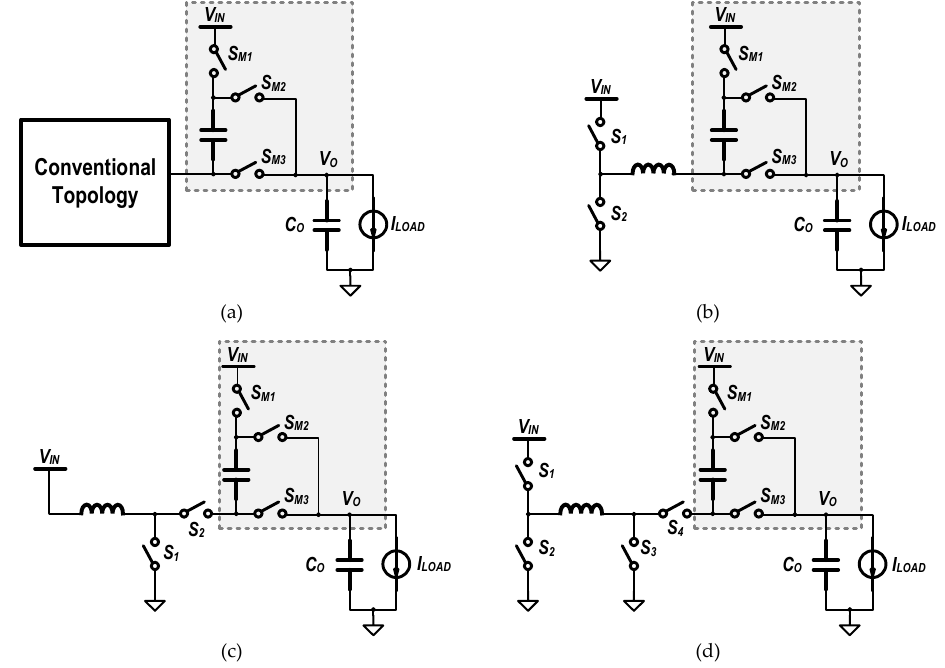
Figure 5. ( a ) Conventional topology with an energy transfer media; ( b ) buck converter; ( c ) boost converter; ( d ) buck-boost converter.